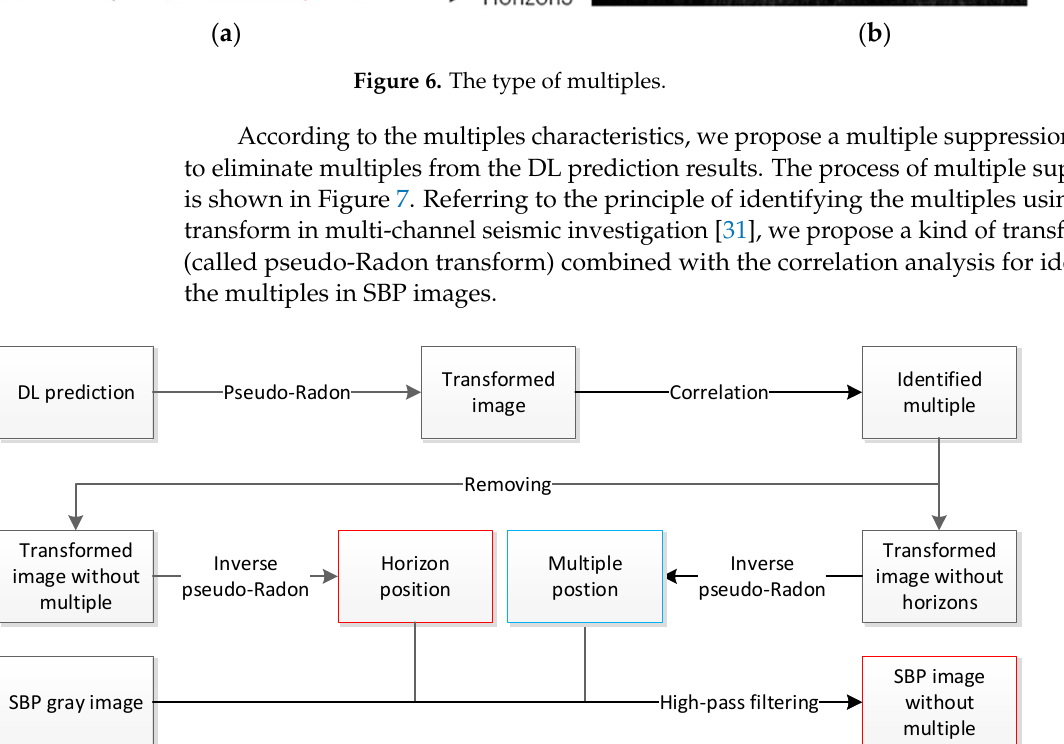
Figure 6. The type of multiples.